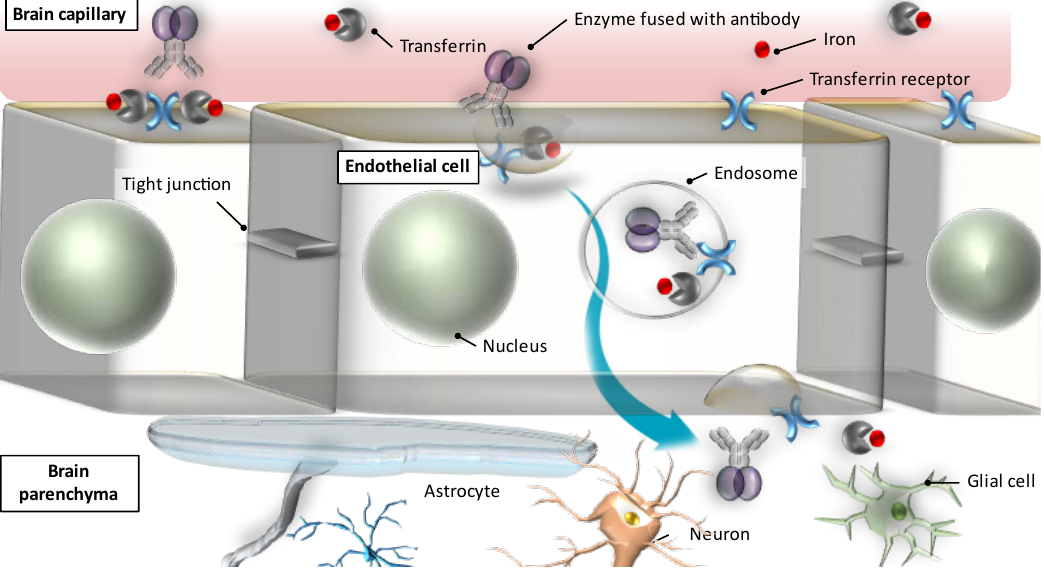
Figure 1. A schematic representation of transferrin receptor-mediated transcytosis in the blood–brain barrier (Revised from Yamamoto and Kawashima [46]).